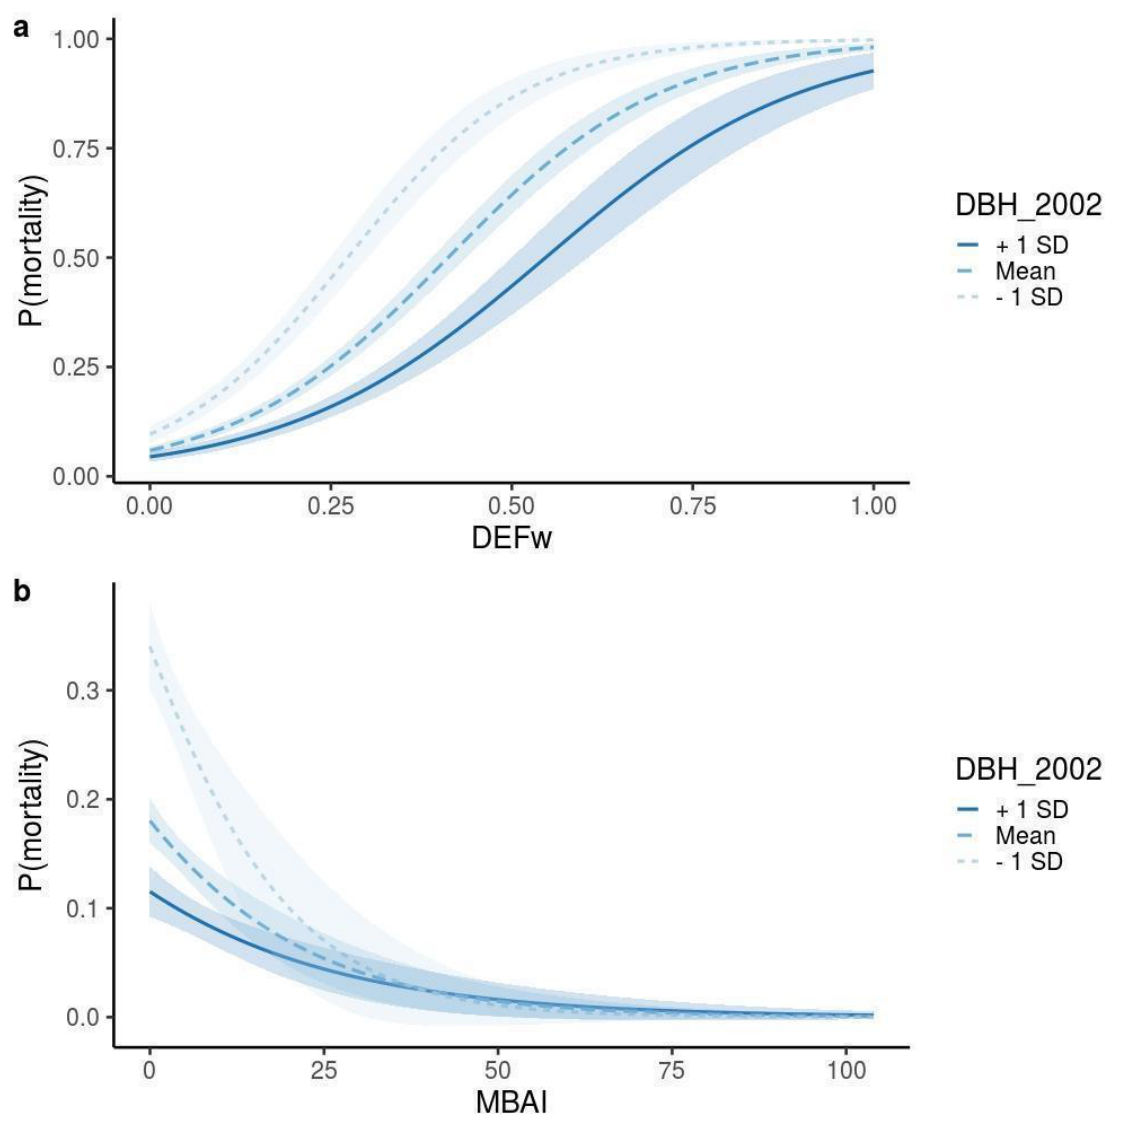
Figure 4. Interaction effects in the logistic regression model for individual mortality rates (a) between diameter (DBH2002) and weighted defoliation (DEFw). (b) between DBH2002 and the mean growth in basal area (MBAI). Regression lines are plotted for three values of DBH2002, corresponding to ± 1 standard deviation (10.7 cm) from the mean (22 cm). Confidence intervals at 95% are shown around each regression